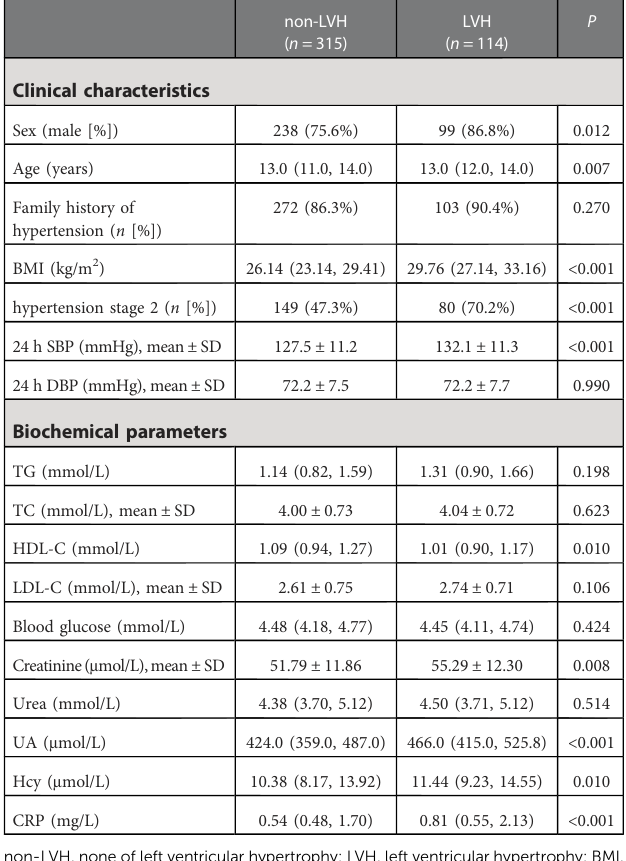
TABLE 1 Clinical characteristics and biochemical parameters in LVH and non-LVH